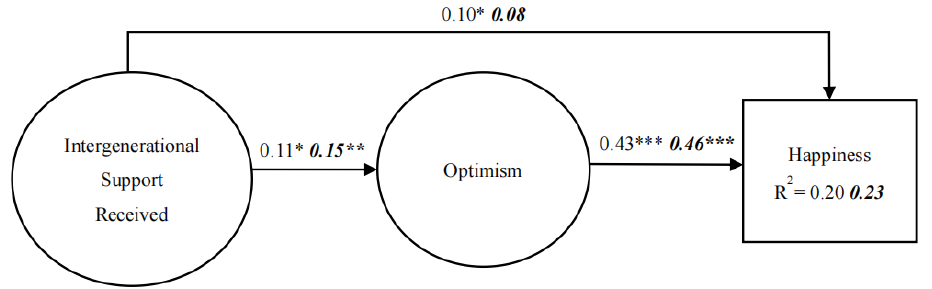
Figure 2. Sex comparison. Note . The coefficients in regular print and those in bold italics represent the results for male and female samples, respectively.*** p < 0.001; ** p < 0.01; * p < 0.05.